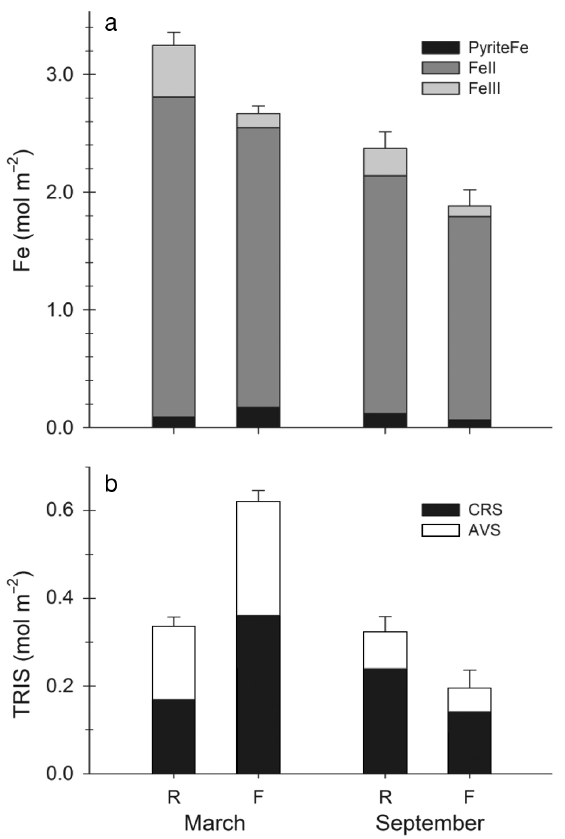
Fig. 5. Depth-integrated (0 to 10 cm depth), area-specific pools of (a) total Fe and (b) total reduced inorganic sulphides (TRIS) at the reference (R) and farming (F) locations in March and September. The different colours of bars indicate the relative contribution of different Fe- or S-compounds to total Fe and TRIS (AVS: acid volatile sulphides, CRS: chromium reducible sulphides, PyriteFe: Fe bound in pyrite). Error bars represent SE (n =